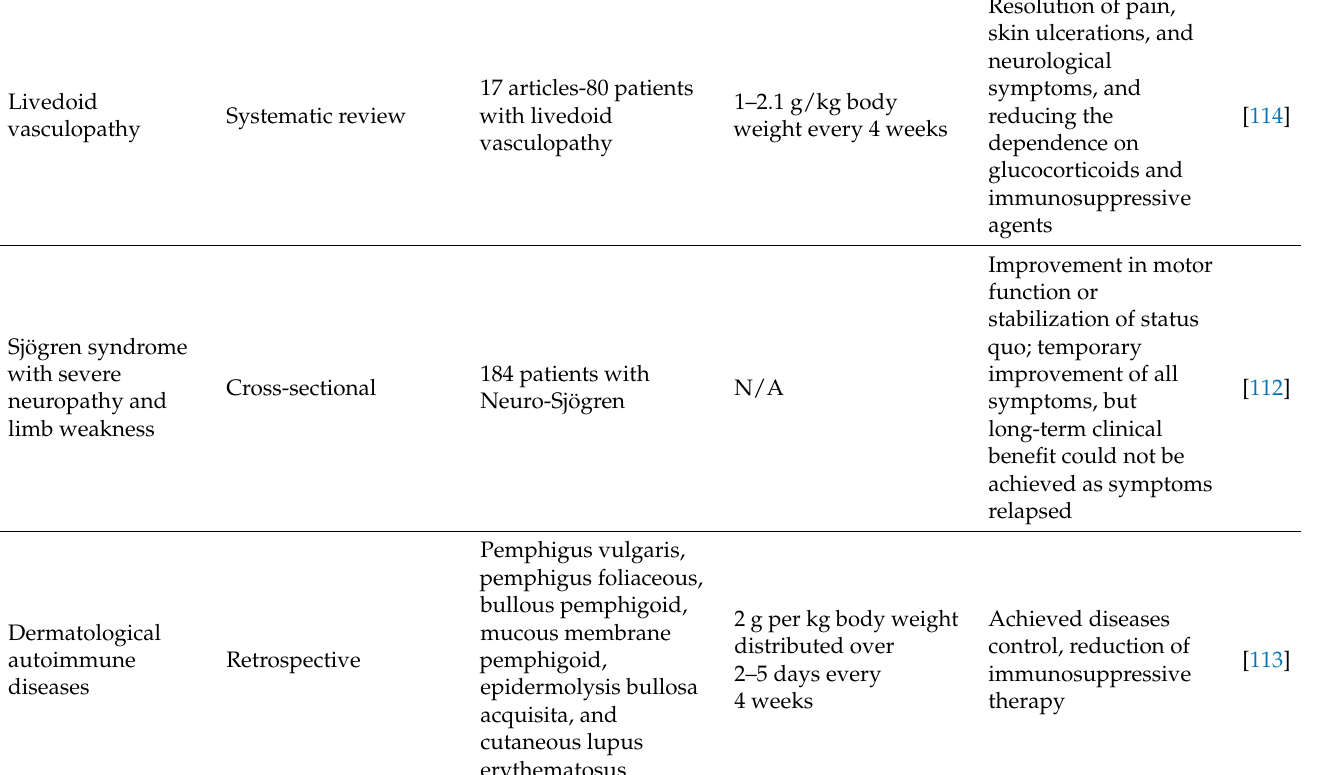
Different maternal immune cells and factors are involved in the immune